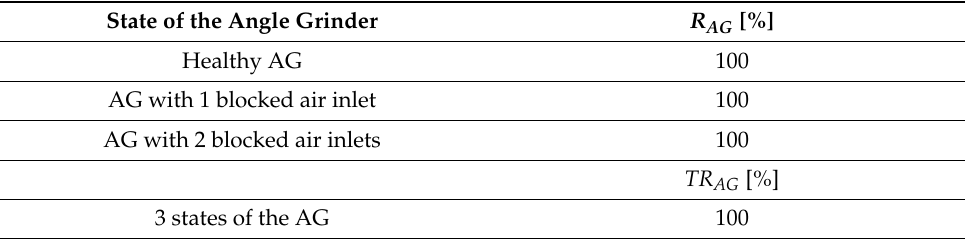
Table 2. Values of TR AG and R AG for using of BCAoMID − F, histogram, and NN classifier. State of the Angle Grinder